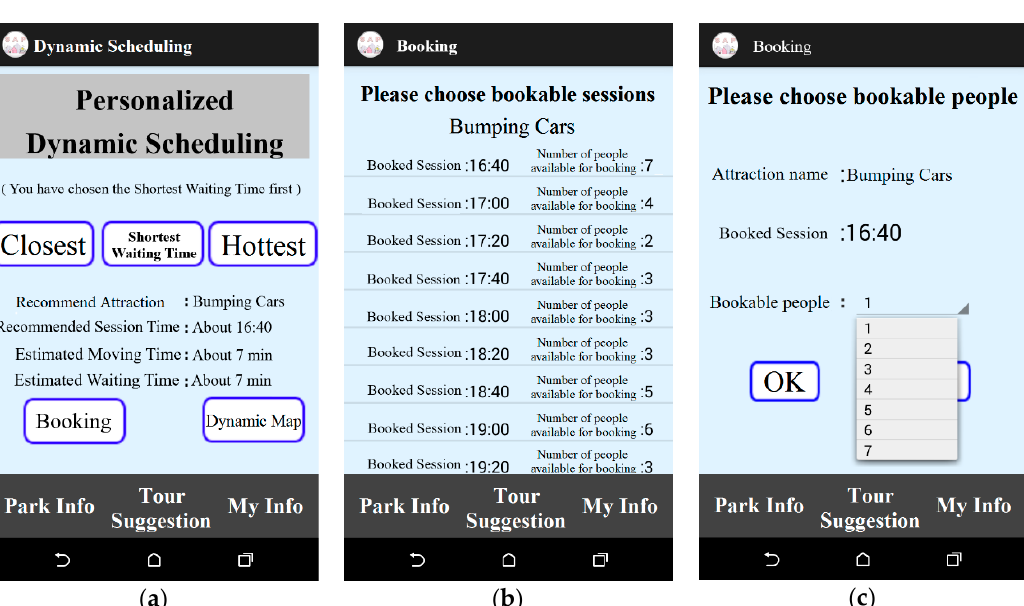
Figure 11. Testing steps of the attraction reservation function: ( a ) example result of the recommended attraction; ( b ) list of available sessions and capacities; and ( c ) selection of the number of visitors to book.